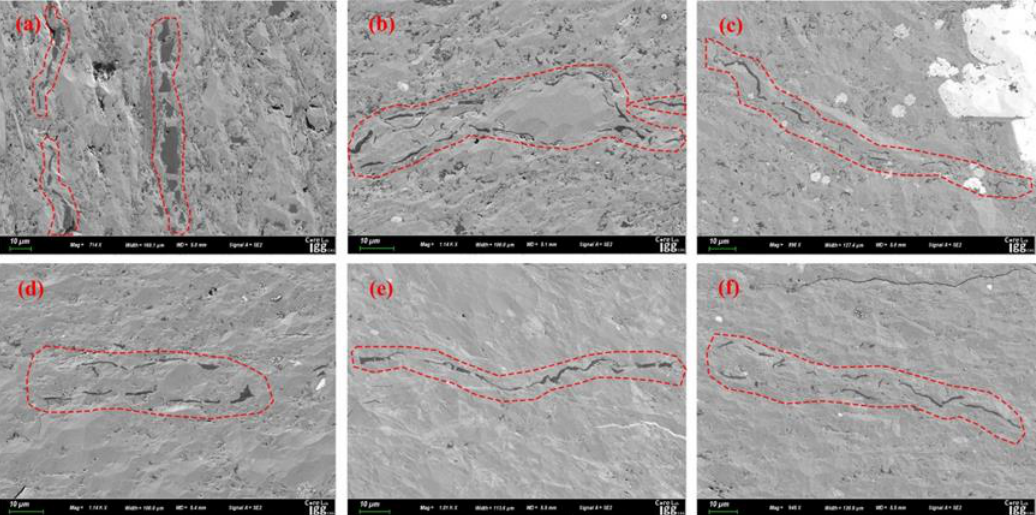
Figure 4. SEM images of the graptolites in the Longmaxi shales: ( a ), XH-27, l ength = 160.1 μm; ( b ), XH-23, l ength = 100.0 μm; ( c ) XH-15, l ength = 127.4 μm; ( d ), XH-9, l ength = 100.0 μm; ( e ), XH-5, l ength = 113.6 μm; ( f ), XH-1, l ength = 120.9 μm .